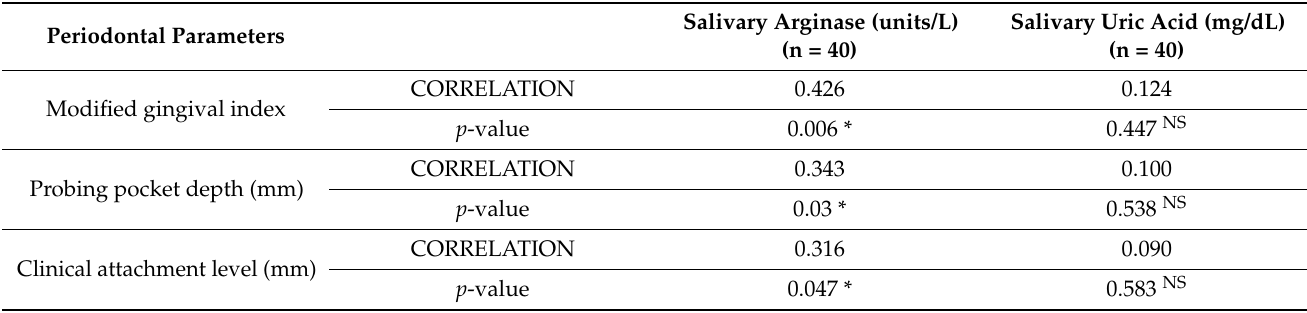
Table 4. Karl Pearson correlation analysis of salivary arginase and uric acid levels and all periodontal parameters on the 90th day for groups II and